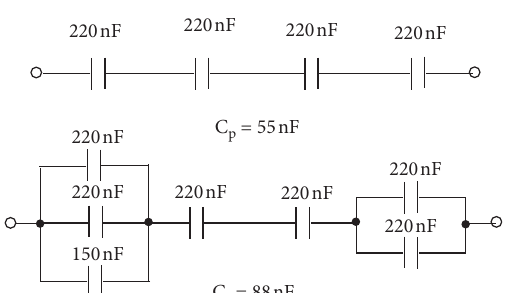
Figure 11: Association of the capacitor sets. (a) C � 88nF. C s